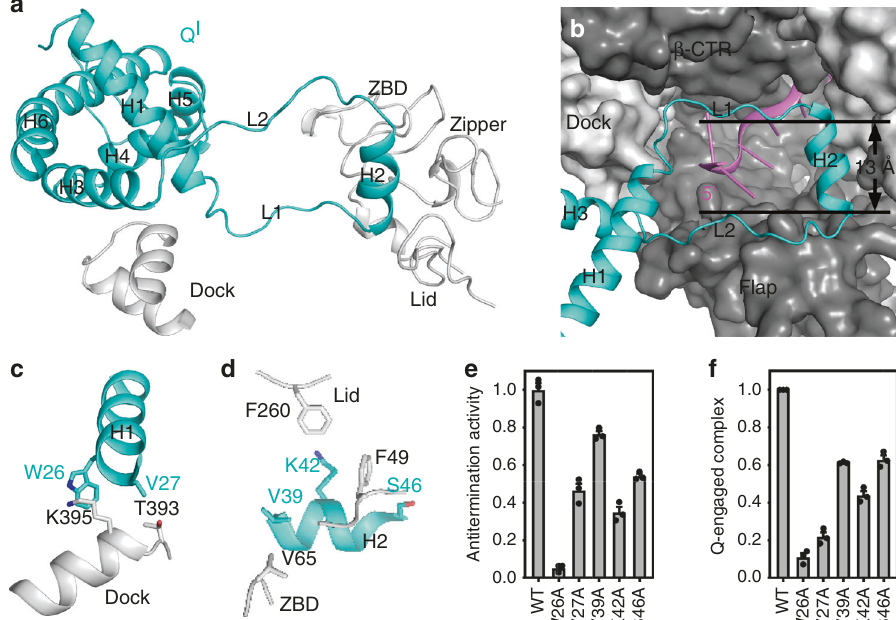
Fig. 4 Q I -RNAP interactions that mediate Q I engagement. a The main portion of Q I interacts with β ' dock, while H2 inserts into the RNA exit channel and interacts with the zipper, lid, and ZBD. Cyan, Q I ; gray, β ′ . b H2, L1, and L2 form a ring-like structure inside the RNA exit channel. RNAP is shown as surface. ZBD is omitted for clarity. Dark gray, β ; light gray, β '; cyan, Q I ; pink, RNA. c Interactions between H1 and β ' dock. d Interactions between H2 and the zipper, lid, and ZBD. e Effects on antitermination of substitutions of H1 and H2 (mean ± SEM; 3 determinations). f Effects on Q engagement of substitutions of H1 and H2 (mean ± SEM; 4 determinations). Error bars represent mean ± SEM out of n = 3 experiments. Source data are provided as a Source Data fi le